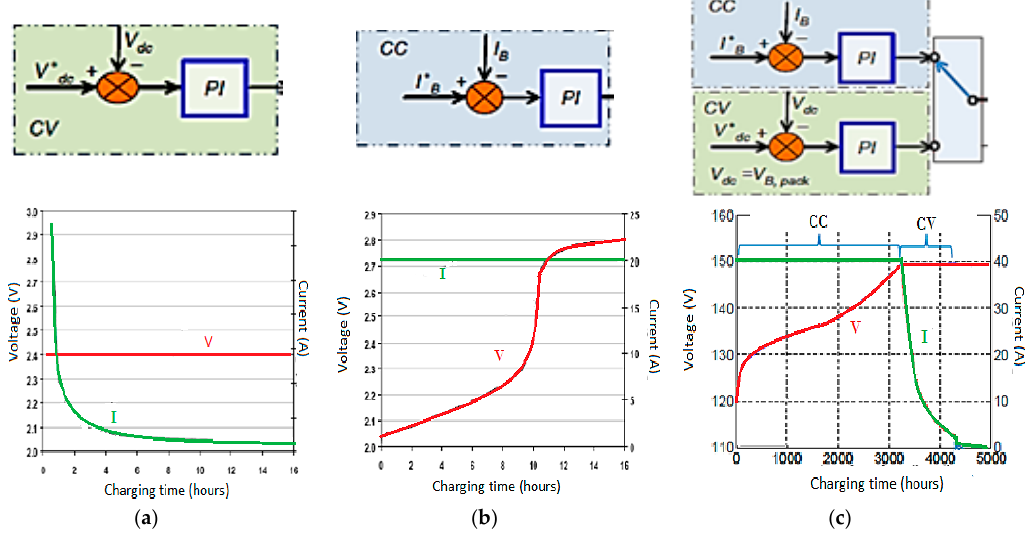
Figure 9. Charging methodologies control blocks and Voltage-Current Curves . ( a ) CV Charging; ( b ) CC Charging; ( c ) CC-CV Charging.